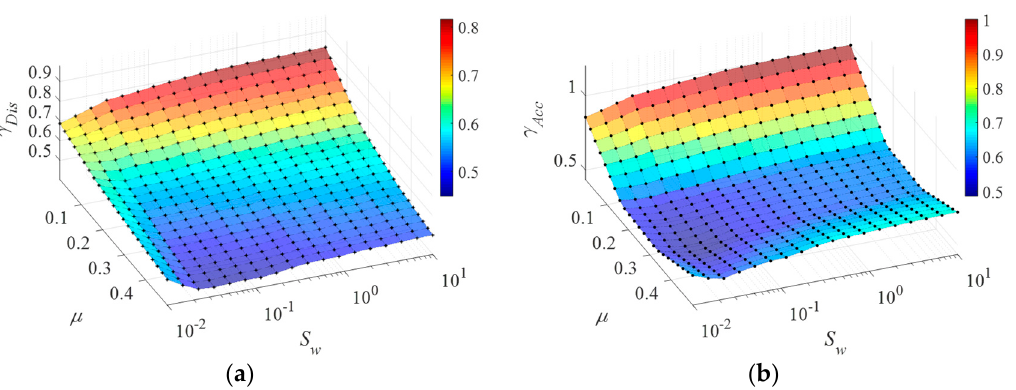
S : (a) γ and (b) γ w Dis